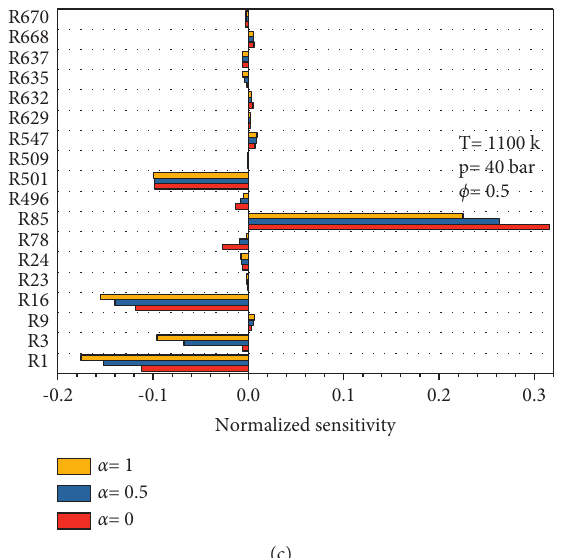
Figure 16: Reaction sensitivity analysis of the ignition delay time for various α values in the different temperature ranges for methane/ syngas/n-heptane mixtures at β � 2.112 × 10 − 2 , p � 40 bar, and ϕ �